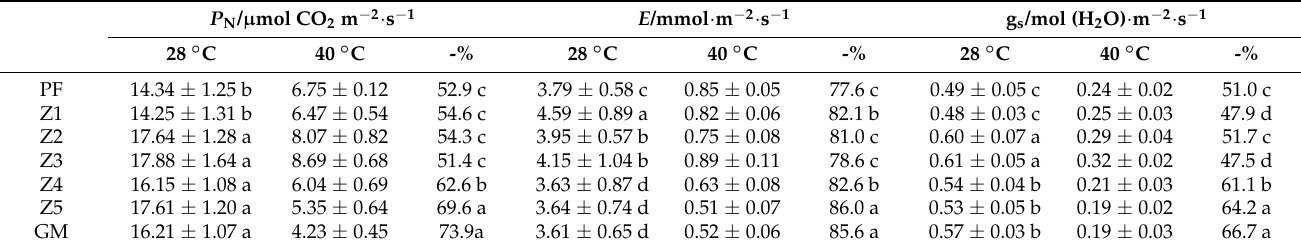
Table 2. P N , E, and g s of different